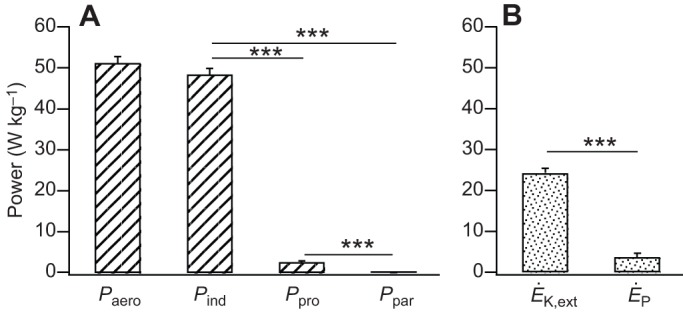
Partitioning of the aerodynamic power requirements during escape take-off flight in blue tits. (A) Total aerodynamic power (Paero) during take-off and its partitioning into separate aerodynamic components (induced power, Pind; profile power, Ppro; parasite power, Ppar). (B) The apportioning of the total power of the centre of mass (PCoM) into the rates of change of potential and kinetic energies (ĖP and ĖK,ext). Note that the power of the centre of mass is a component of the induced power (see Askew et al., 2001). Bars represent mean values with s.e.m., and significant differences are shown (***P<0.001, N=29).